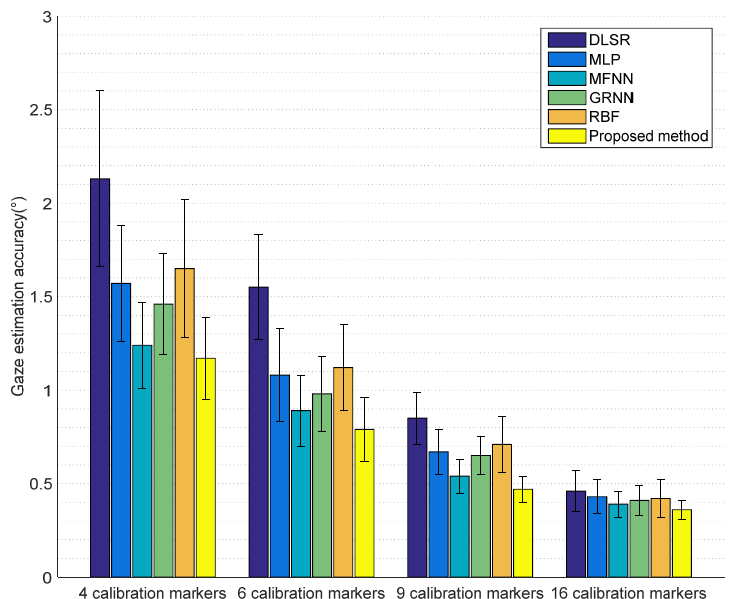
Figure 11. Comparison of gaze estimation accuracy results between proposed method and other methods considering error compensation.